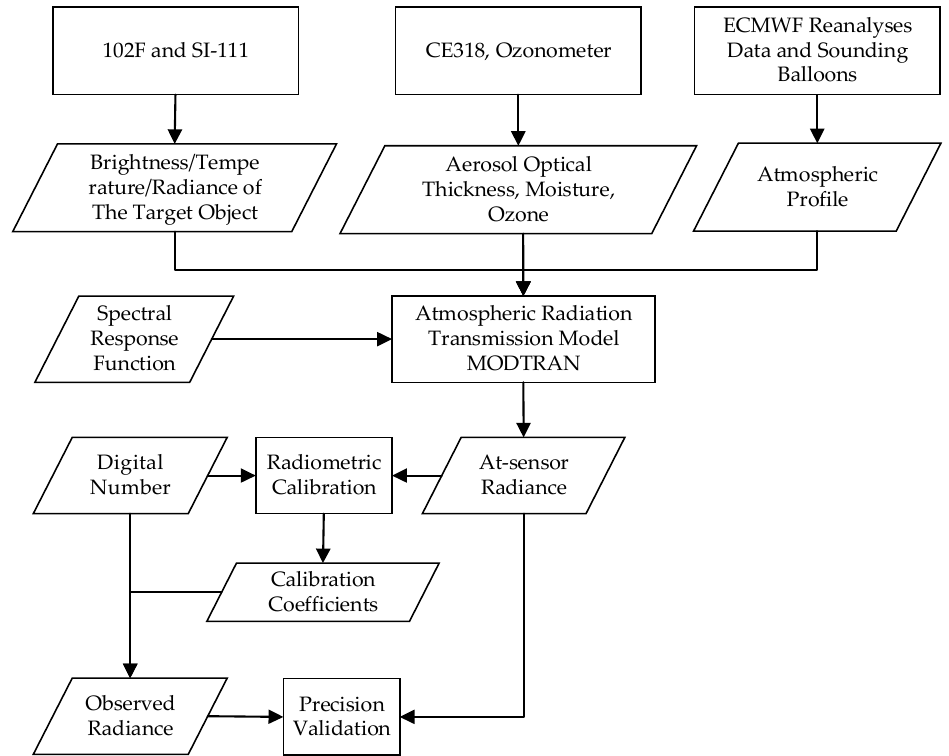
Figure 2. ZY1-02E on-orbit absolute radiation calibration and accuracy